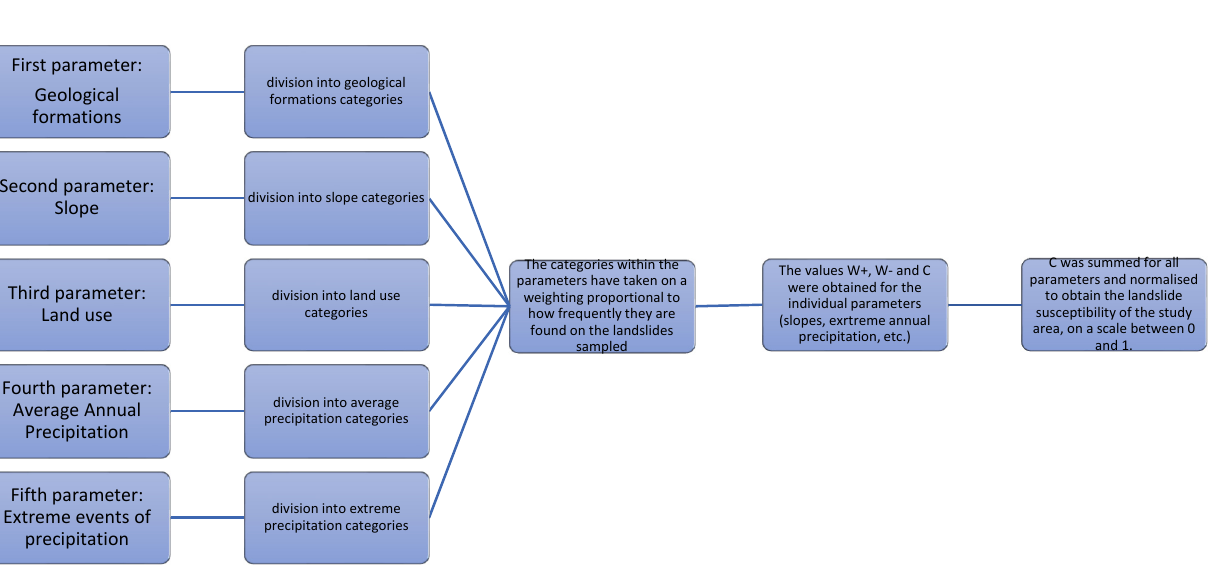
Figure 4. Model flow diagram.